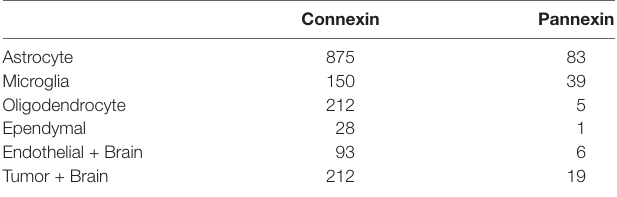
TABLE 1 | Number of original research articles found for the keyword combinations used for the literature search in PubMed and Scopus citation